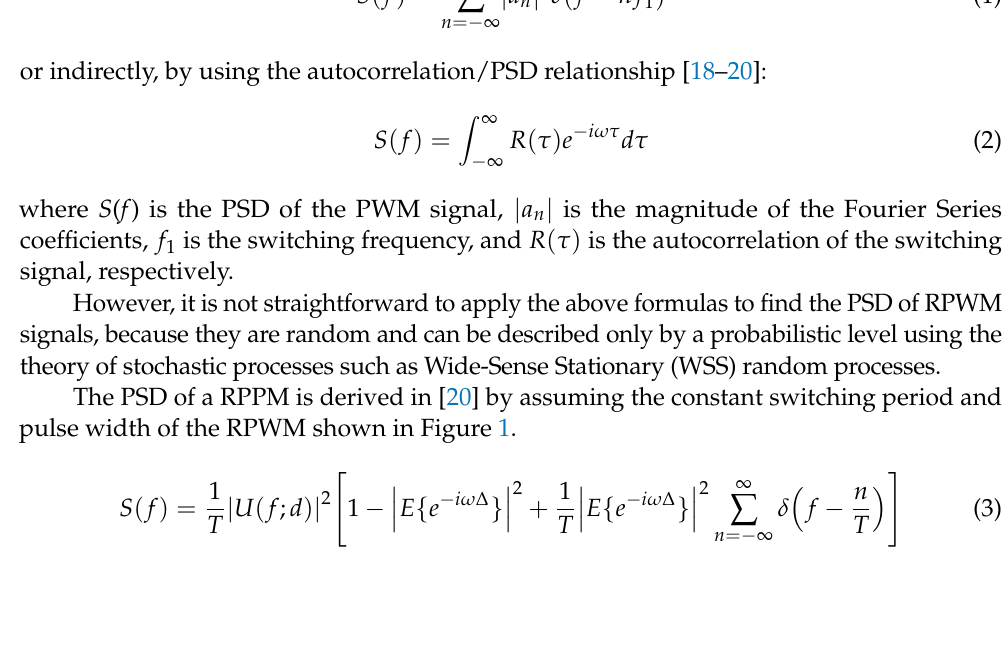
Figure 2. PSD of the switching signal with uniformly distributed random pulse position.